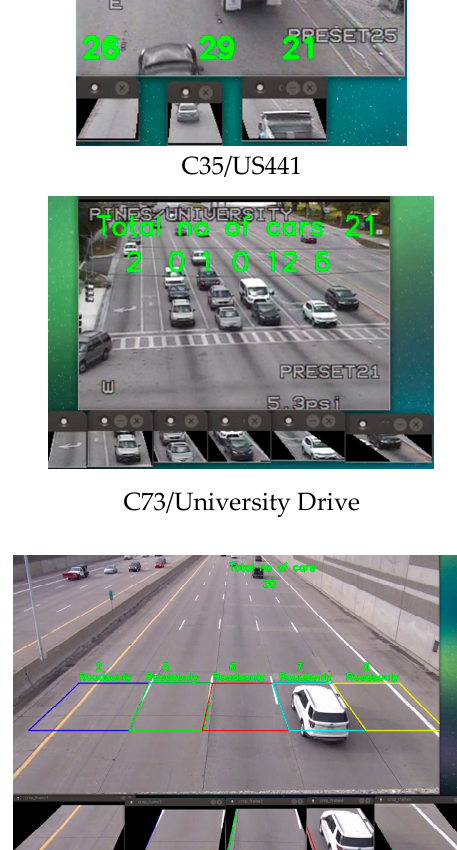
Figure 8. OverFeat network results.